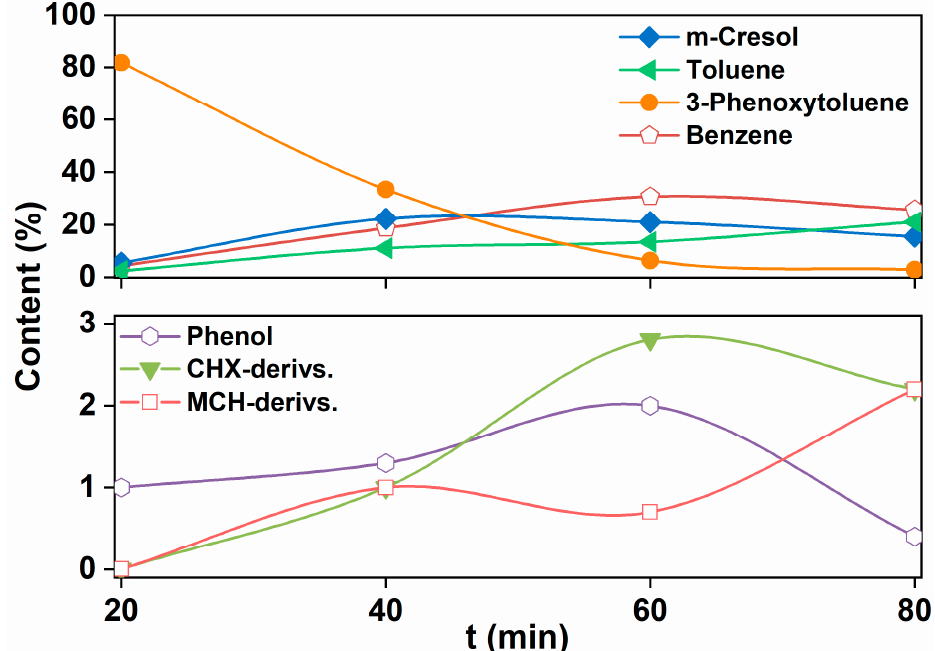
Figure 8. Time profiles of hydrogenolysis of 3-phenoxytoluene over Ru-Ni 12 P 5 /S-1 5 . CHX-derivs: Cyclohexene-derivatives, including cyclohexane, cyclohexanol, and cyclohexanone; MCH-derivs: methylcyclohexane-derivatives, including methylcyclohexane, 3-methylcyclohexanol and 3-methylcyclohexanone.